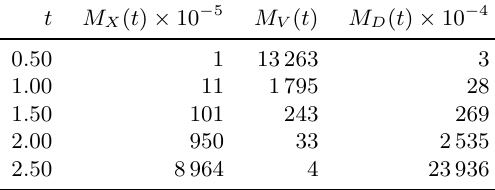
M X ( t ) , M V ( t ) and M D ( t ) as a function of t (after treatment) with C = 3 , N = 412